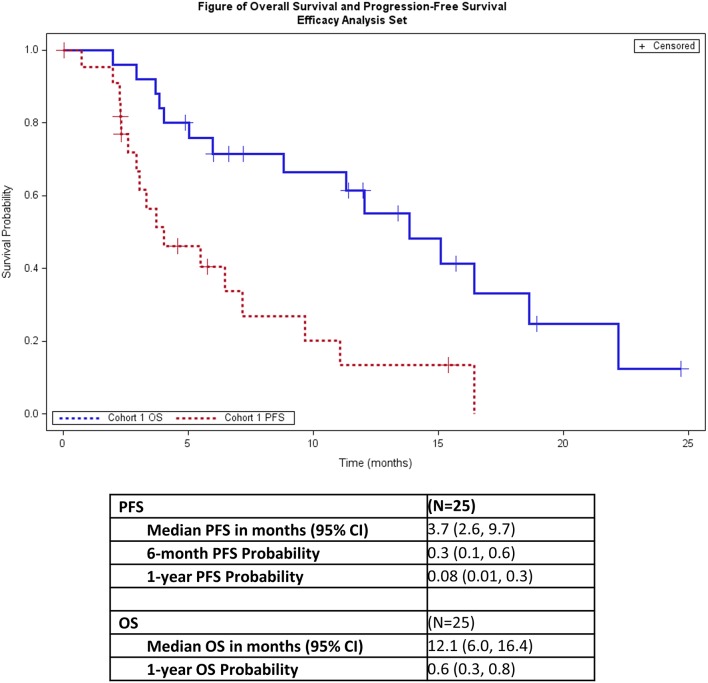
Progression-free survival and overall survival.